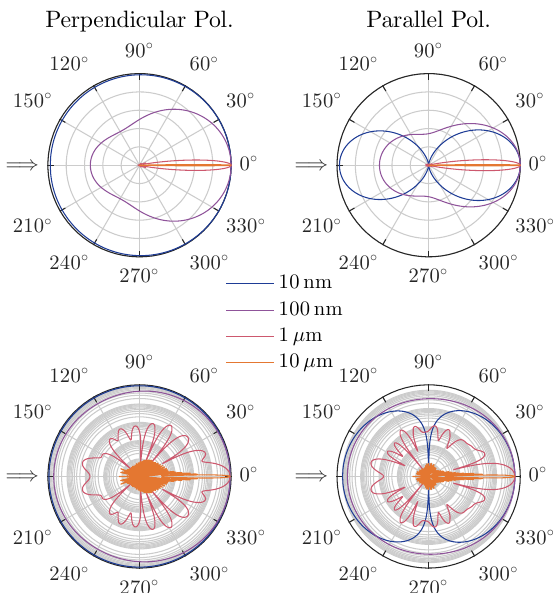
Figure 13. Normalized perpendicular (left) and parallel (right) polarized components of the scattering intensity of light from a TiO 2 (rutile) single particle with a diameter from 10nm (blue) to 10µm (orange) with respect to a linearly polarized plane wave with a wavelength λ = 500nm coming from the left (marked by an arrow). Top: linear scale, bottom: logarithmic